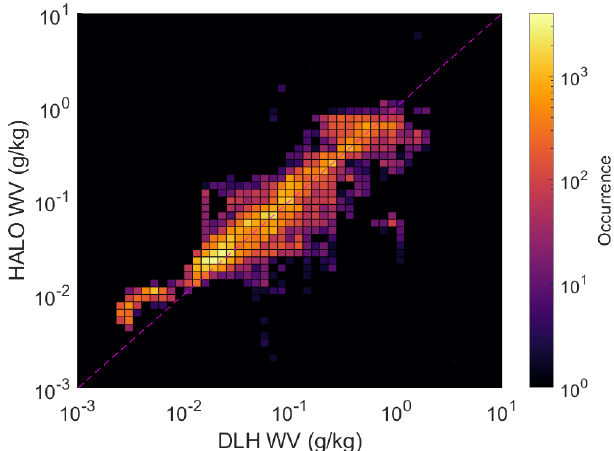
Figure 9. Plot of DLH versus HALO WV on log scales and aggre- gated over all available data, with color indicating the number of points in each bin. The dashed line is a one-to-one line. HALO data are the average of the five highest-altitude measurements, ∼ 400m below the